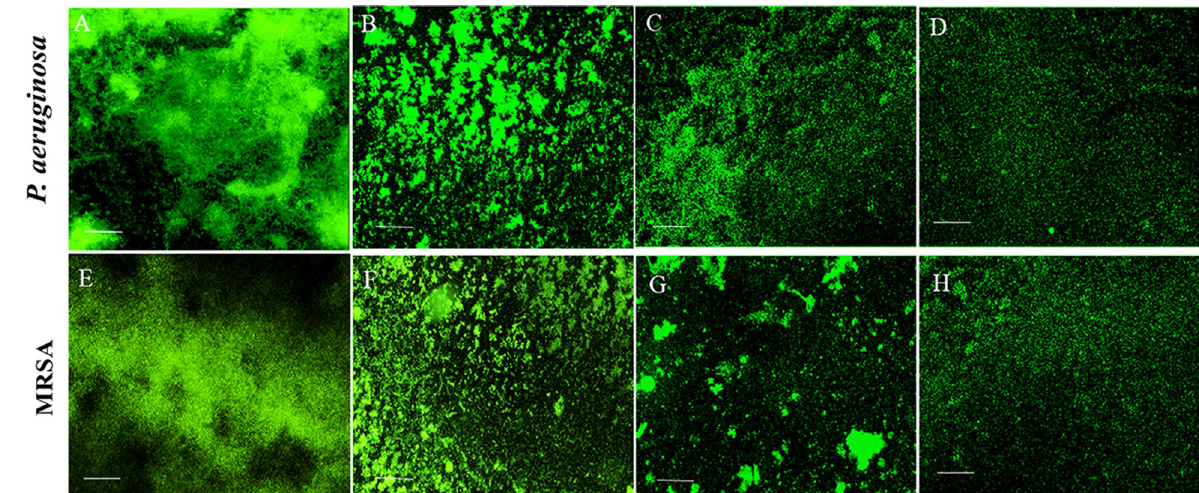
Figure 11. Acridine orange stained P.aeruginosa and MRSA biofilms with treatment combinations. ( A , E ) Control biofilms without treatment, ( B , F ) Biofilms treated with LP alone, ( C , G ) Biofilms treated with Cu-NPs alone, ( D , H ) Biofilms treated with LP + Cu-NPs (50 µM).